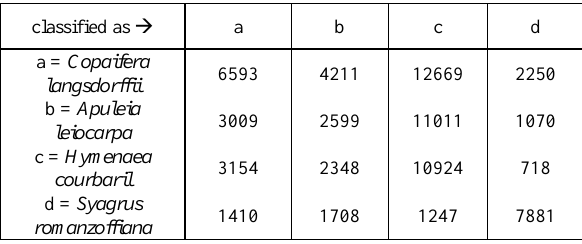
Table 5. Confusion matrix of the validation set when RF model